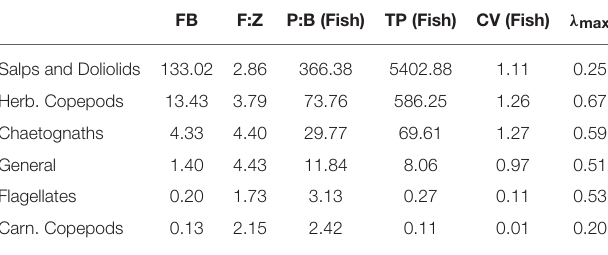
TABLE 4 | Fish community biomass (FB), fish to zooplankton biomass ratio (F:Z), fish community production to biomass ratio (P:B) and throughput (TP), the variation in fish community biomass (coefficient of variation; CV) and the maxmium real part of the Jacobian ( λ max ) when the zooplankton community is defined by the feeding characteristics of different functional groups. FB F:Z P:B (Fish) TP (Fish) CV (Fish) λ max Salps and Doliolids 133.02